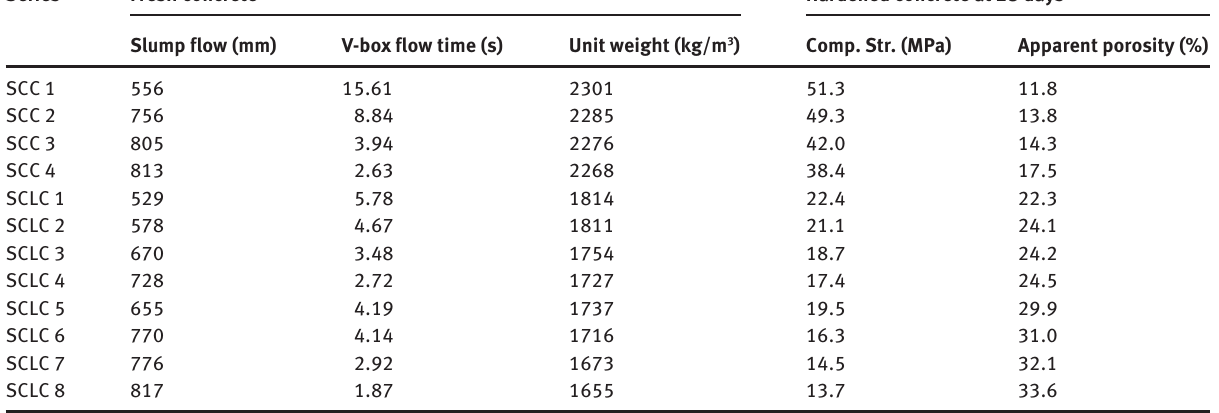
Table 4 Fresh and hardened concrete properties of SCC and